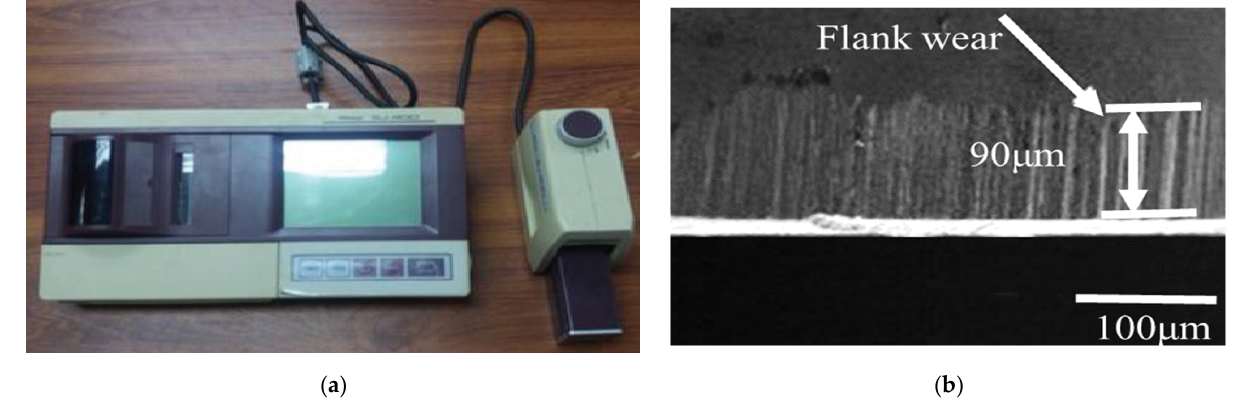
Figure 2. ( a ) Surface roughness testing machine; ( b ) SEM of tool wear. Table 3. Experimental runs based on definitive screening design and measured